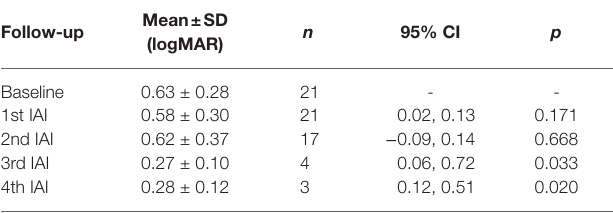
TABLE 1 | Baseline characteristics of the patients.